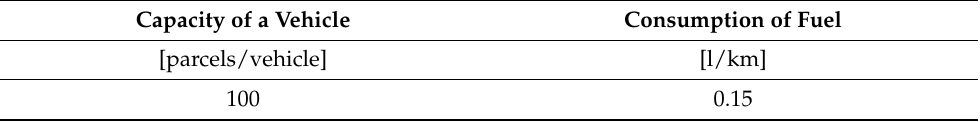
Table 1. Assumptions for calculations.